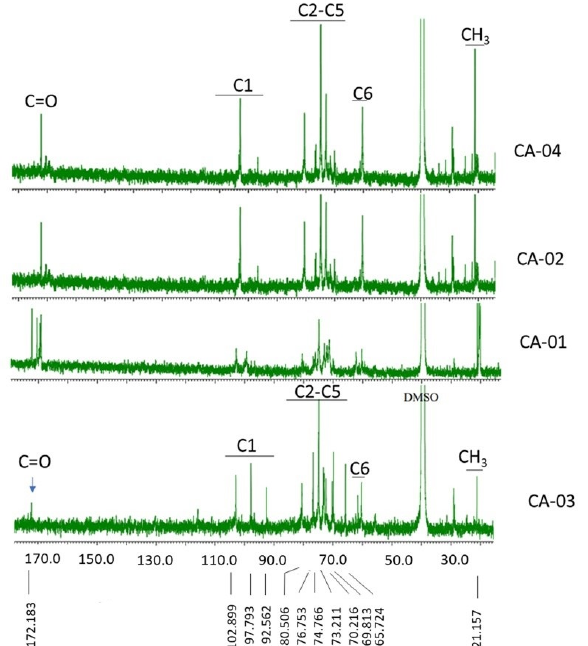
Figure 4. 13 C NMR spectra of